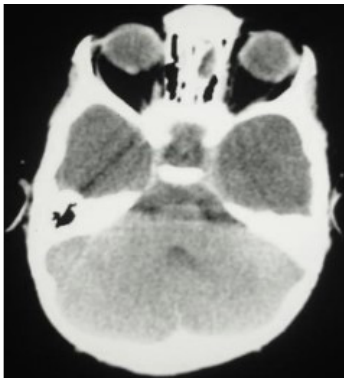
Figure 1. Axial section of skull computerized tomography without contrast showing supratentorial hypodensity, diffuse cerebral edema and hyperdensity of the cerebellar